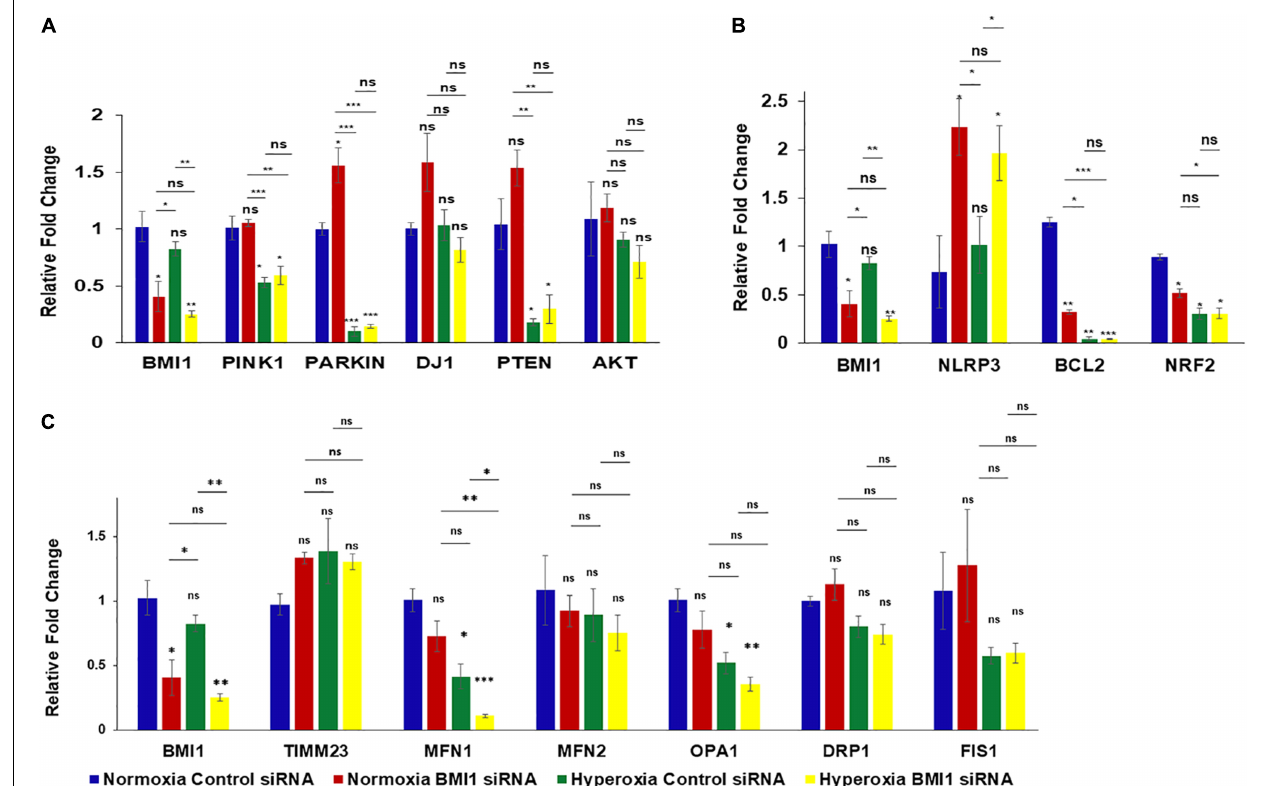
FIGURE 3 | Analysis of transcript levels in BMI1 silenced H441 cells exposed to hyperoxia. (A) qRT-PCR analysis of transcripts involved in mitophagy pathway in BMI1 silenced vs. non-silenced H441 cells exposed to NO and HO. (B) qRT-PCR analysis of transcripts related to ALI in BMI1 silenced vs. non-silenced H441 cells exposed to NO and HO. (C) qRT-PCR analysis of transcripts related to mitochondrial dynamics in BMI1 silenced vs. non-silenced H441 cells exposed to NO and HO. All the four groups were compared to each other using MANOVA. Data represented as mean ± SEM, n = 3, ns = not significant, * p ≤ 0.05, ** p ≤ 0.01, *** p ≤